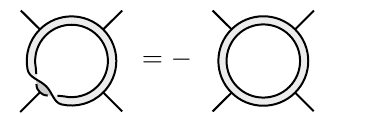
Figure 6 . The antisymmetry of the three-point vertex converts non-planar contributions to planar. in(cid:12)nitesimally close. This can not happen for the leg 1, which is always on the opposite side of the annulus. This reasoning is illustrated in (cid:12)gure